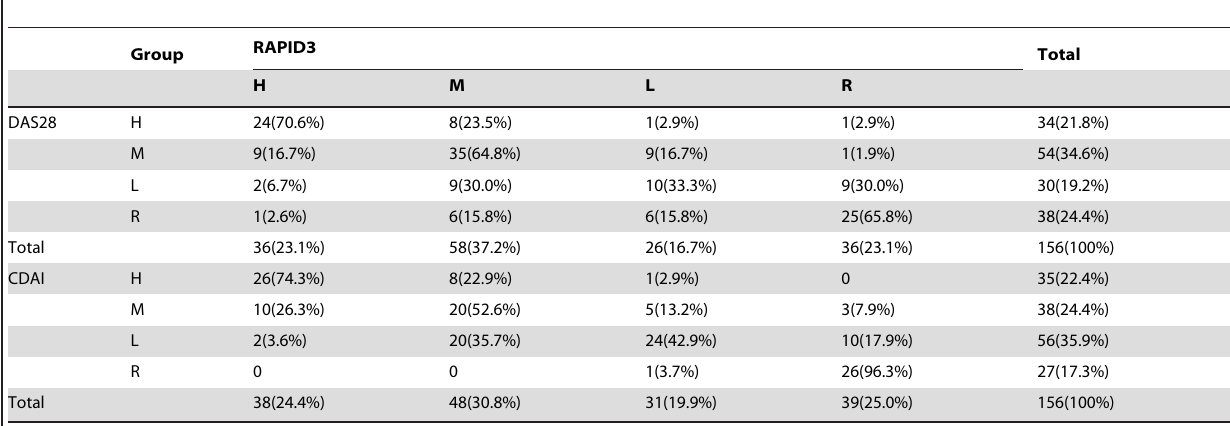
Table 6. The cross-tabulation of RAPID3 scores compared with DAS28 and CDAI in four categories.